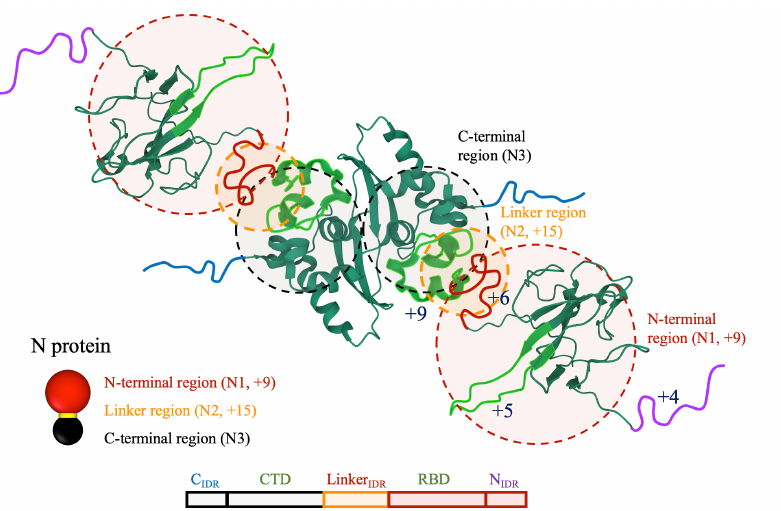
Figure 2. Schematic view of an N protein. The dimerization domain (CTD) of the N protein and the RNA binding domain (RBD) are obtained from PDB 6ZCO and 6YI3, respectively [50,51]. The intrinsic disorder regions (C IDR , Linker IDR , N IDR ) are obtained from UniProt P0DTC9. The visualization is performed through RCSB 3D-view, where the concentrated positive charges are colored light green; the rest of the regions have a zero net charge. The shaded circles indicate the coarse-grained model including three spherical particles: the N-terminal region (N1, red), the linker region (N2, yellow), and the C-terminal region (N3,